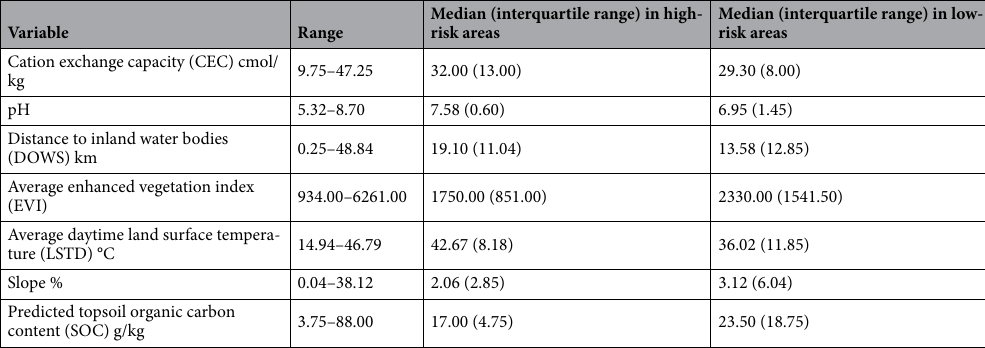
Table 2. Descriptive characteristics of the environmental covariates used to investigate the risk of anthrax in the Ngorongoro Conservation Area.